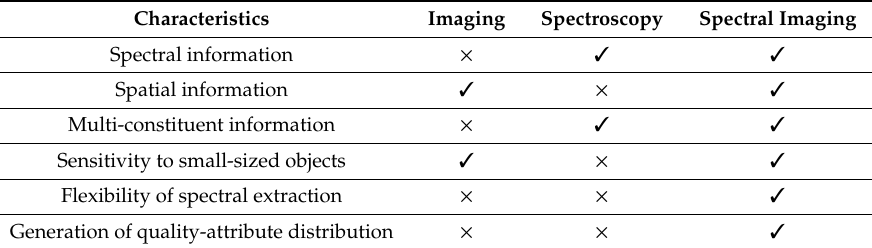
Table 4. Comparison of optics and photonics techniques in agriculture [36].